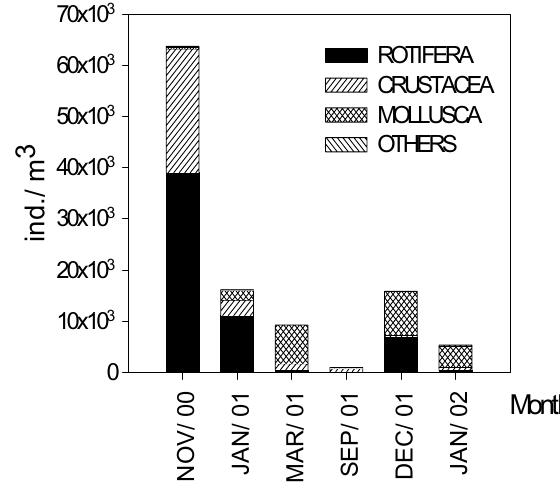
Fig. 3 – Abundance (ind/m 3 ) variation of zooplankton groups in Yí station. Palmar Reservoir,